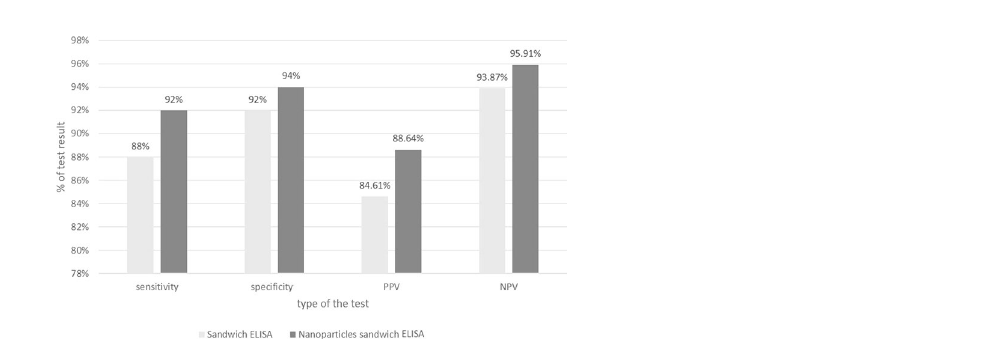
Figure 4. Sensitivity, specificity, positive predictive value (PPV) and negative predictive value (NPV) of both Sandwich ELISA and Nano-Sandwich